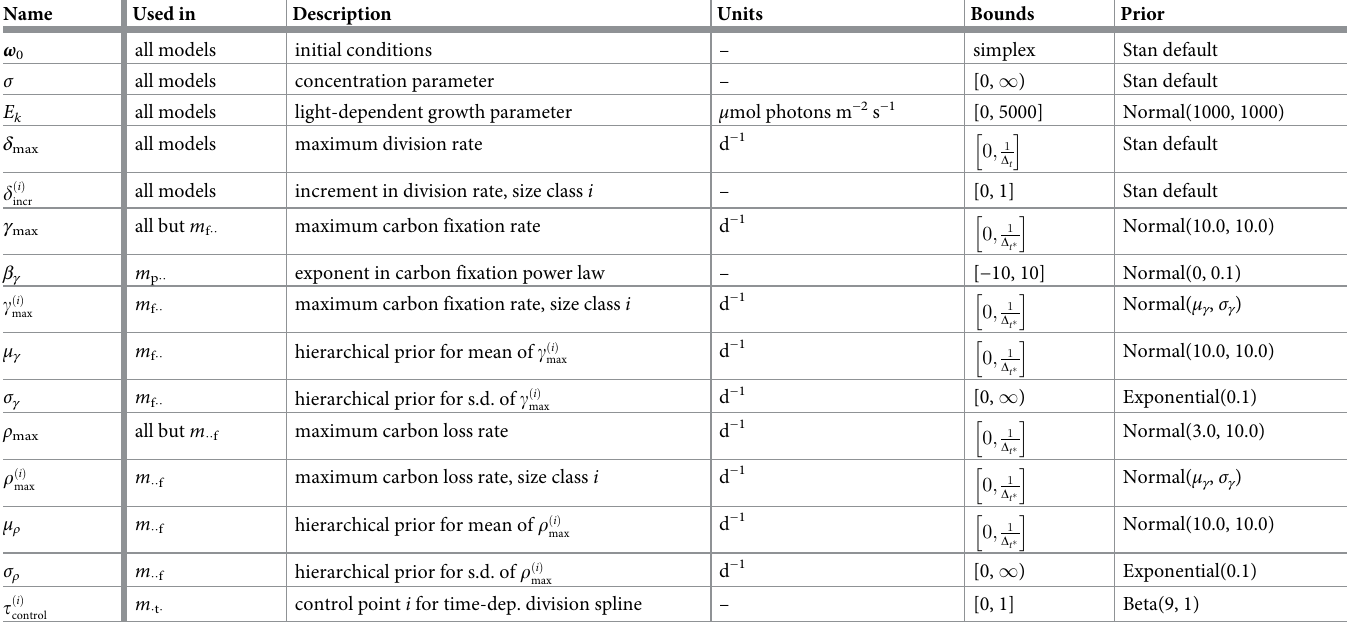
Table 2. List of model